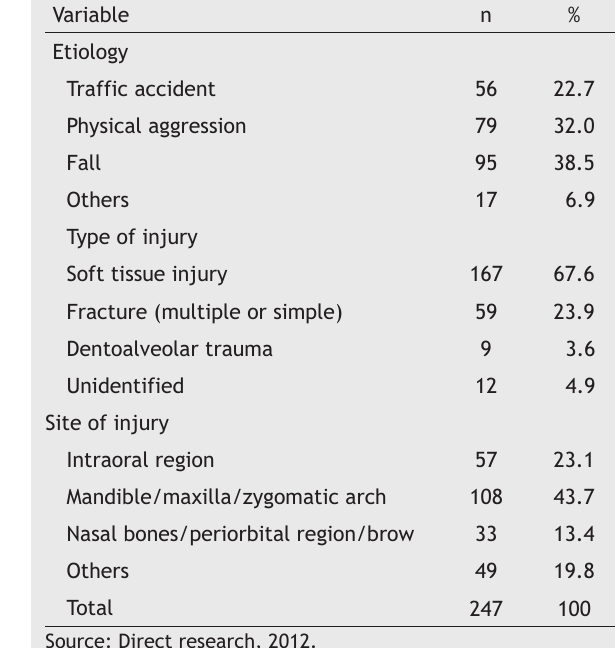
Table 2 Percentage distribution of etiology, type and site of facial trauma: Campina Grande, Brazil, 2012 (n = 247).